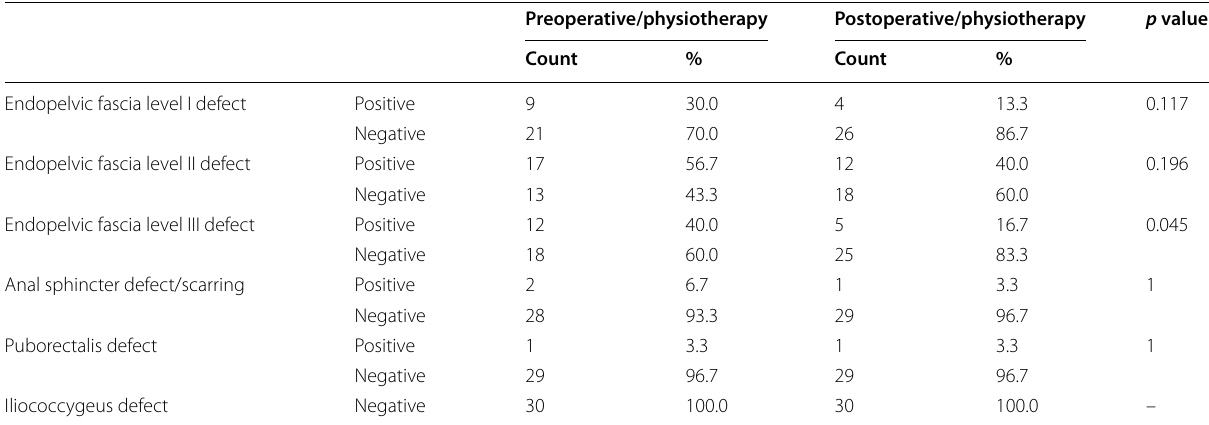
Table 2 Demonstration of static abnormalities detected on MRI of all patients in both pre- and post-intervention